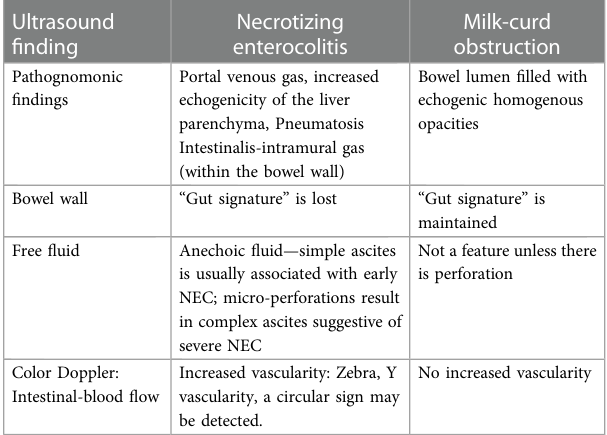
TABLE 1 Comparison of point-of-care abdominal ultrasound fi ndings in necrotizing enterocolitis and milk-curd obstruction. Ultrasound fi